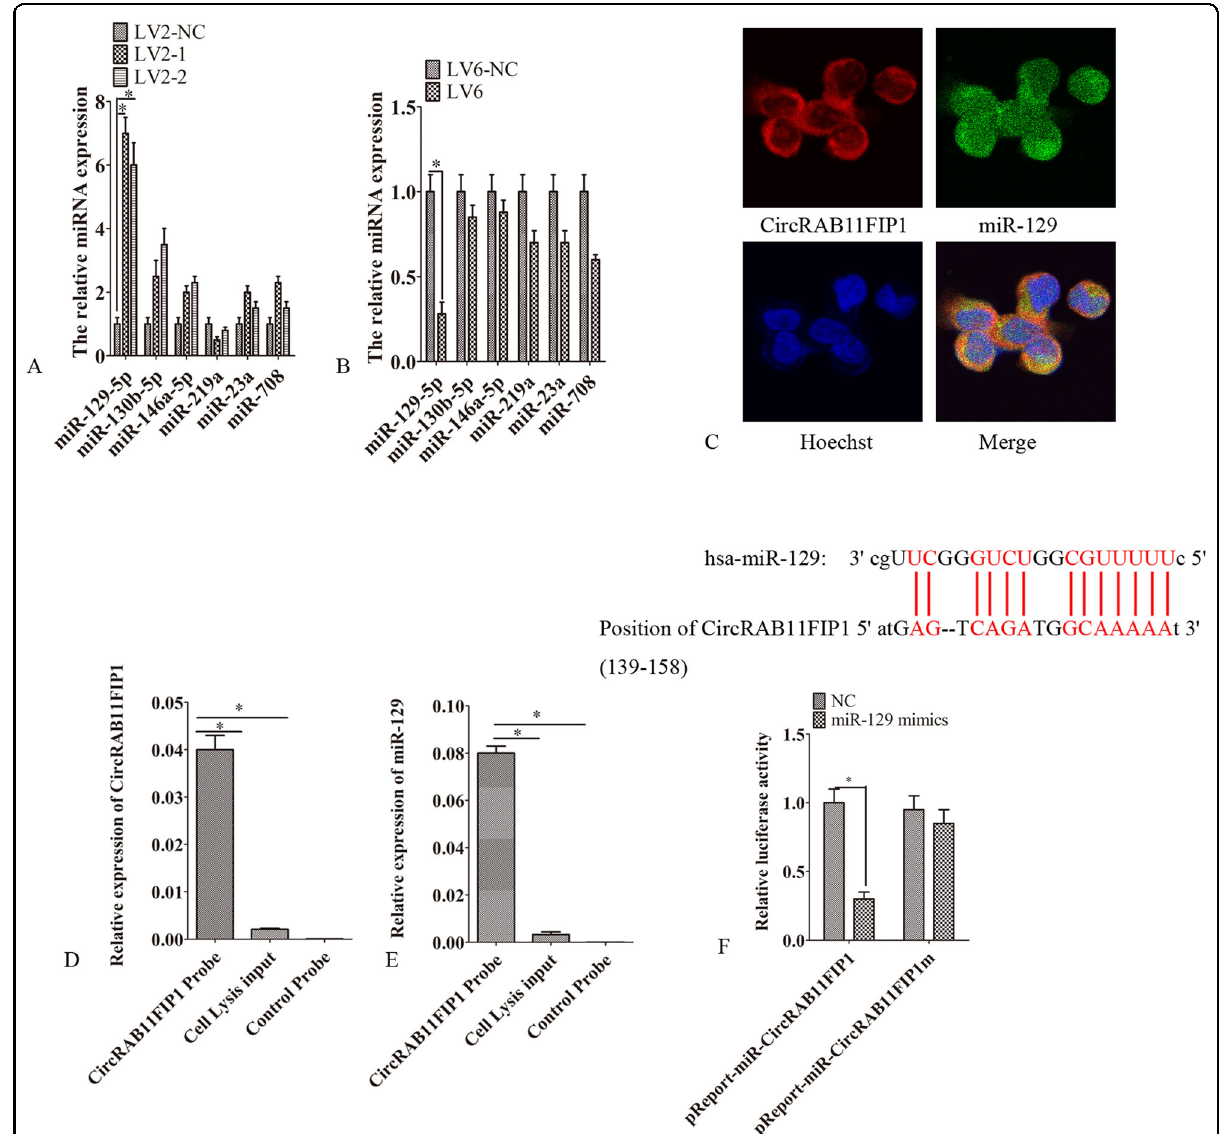
Fig. 4 CircRAB11FIP1 sponged miR-129. A LV2-1, LV2-2, or LV2-NC was transfected into SKOV3 cells. Later, qPCR was performed to detect miRNA expression. B LV6 or LV6-NC was transfected into A2780 cells. Later, qPCR was conducted to detect miRNA expression. C miR-129 together with circRAB11FIP1 positions in SKOV3 cells was determined by the FISH assay. D CircRAB11FIP1 expression decreased in SKOV3 cell lysate, which was enriched by the circRAB11FIP1 probe, as examined using qPCR. E miR-129 expression decreased, which was enriched by the circRAB11FIP1 probe, as veri fi ed through qPCR. F Prediction of possible binding sites in circRAB11FIP1 for miR-129. SKOV3 cells were transfected with miR-129 mimic or NC (NC) RNA together with pMIR-circRAB11FIP1 or pMIR-circRAB11FIP1m, respectively. Thereafter, the luciferase activities were examined. Error bar stands for standard error. * P <